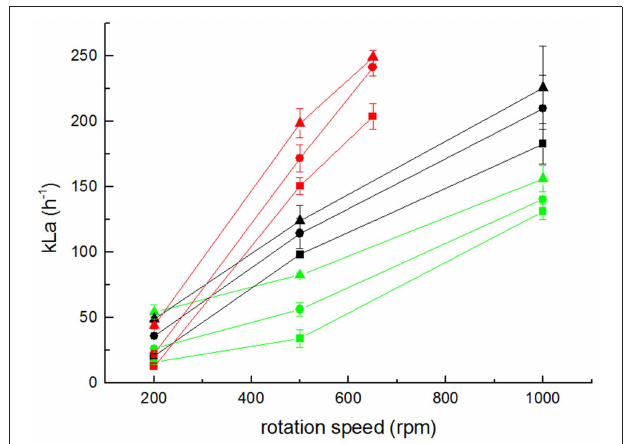
FIGURE 7 | Average values of mixing times θ obtained for the different stirring speeds for setup 3 (squares) and setup 4 (circles) for at least 3 independent determinations ( n ≥ 3). Error bars represent the time resolution of the conductivity meter ( ± 1s).